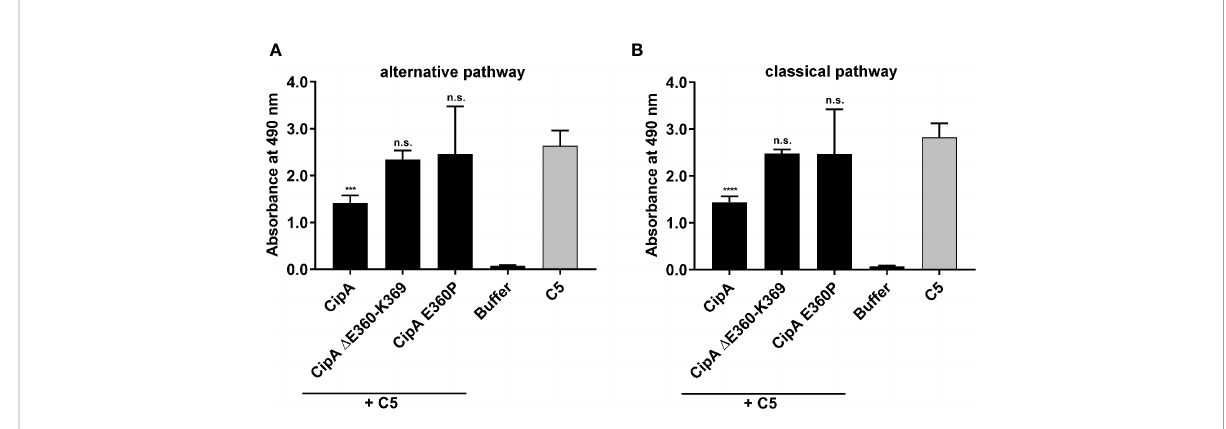
FIGURE 3 Impact of CipA on the enzymatic activity of the C5 convertases. The in fl uence of CipA on the C5 convertase was analyzed by measuring the generation of C5a. The C5 convertases of the AP (A) and CP (B) were constituted on microtiter plates coated with LPS or IgM by adding NHS. Thereafter, reaction mixtures of C5 preincubated with or without CipA variants were added. The generation and release of C5a in the supernatant was then detected by C5a ELISA. Data represent means and standard deviation of at least three independent experiments, each conducted in duplicate. ***, p ≤ 0.0002; ****, p ≤ 0.0001, n.s., no statistical signi fi cance, one-way ANOVA with post-hoc Bonferroni multiple comparison test (con fi dence interval =